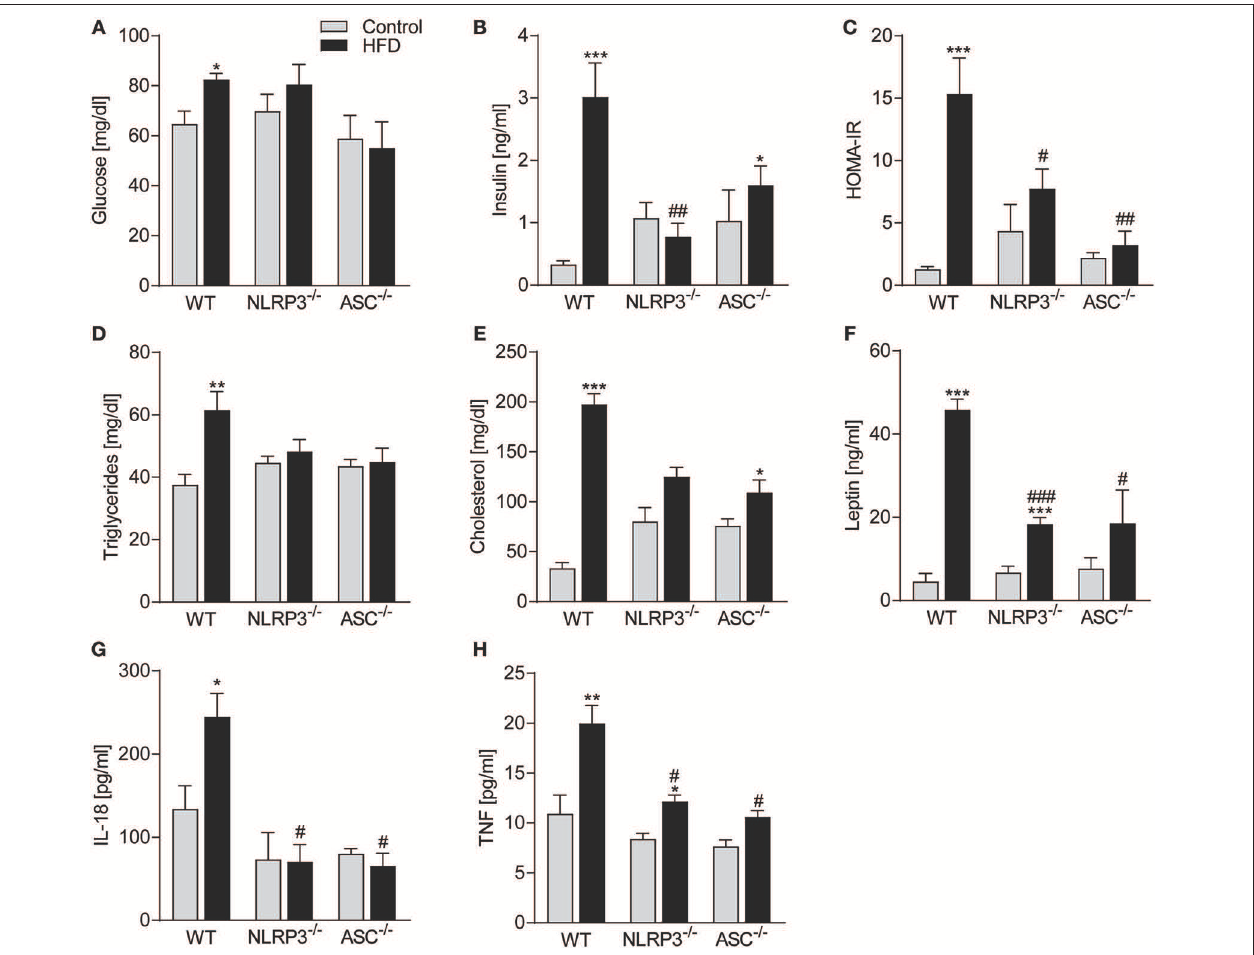
FIGURE 3 | NLRP3 and ASC deficiency protects mice against obesity-induced metabolic dysregulation and inflammation. WT, Nlrp3 − / − , and Asc − / − ( Pycard − / − ) male mice were exposed to a high fat diet (HFD; 60 cal% fat) or a control diet for 52 weeks and plasma was collected. Plasma (A) glucose, (B) insulin, (C) HOMA-IR [homeostatic model assessment of insulin resistance calculated from measured glucose and insulin levels], (D) triglycerides, (E) cholesterol, (F) leptin, (G) interleukin (IL)-18, and (H) tumor necrosis factor (TNF). WT: Control, n = 8; HFD, n = 8, Nlrp3 − / − : Control, n = 8; HFD, n = 7, and Asc − / − : Control, n = 7; HFD, n = 7. Data are means ± SEM. * P < 0.05, ** P < 0.01, *** P < 0.001 vs. control diet; # P < 0.05 vs. WT-HFD as determined by two-way ANOVA and Tukey’s multiple comparisons